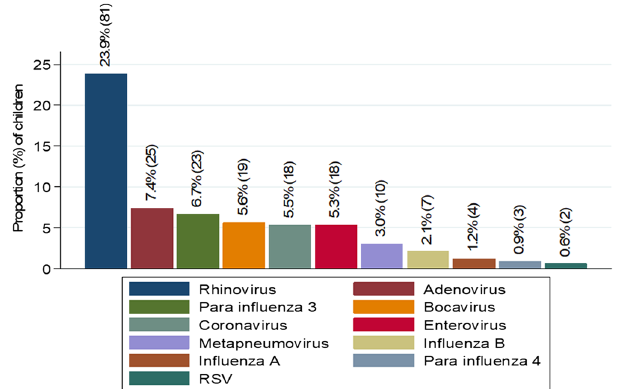
Figure 2. Viral pathogens isolated in the children under 5 years with URTI in Mwanza city.